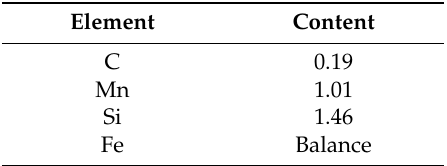
Table 1. Chemical composition (wt %) of the